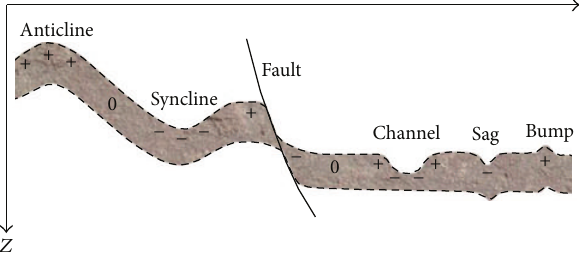
Figure 5: Sign convention for curvature attributes. Positive cur- vature reveals anticlines and reflection bumps; negative curvature reveals synclines and reflection